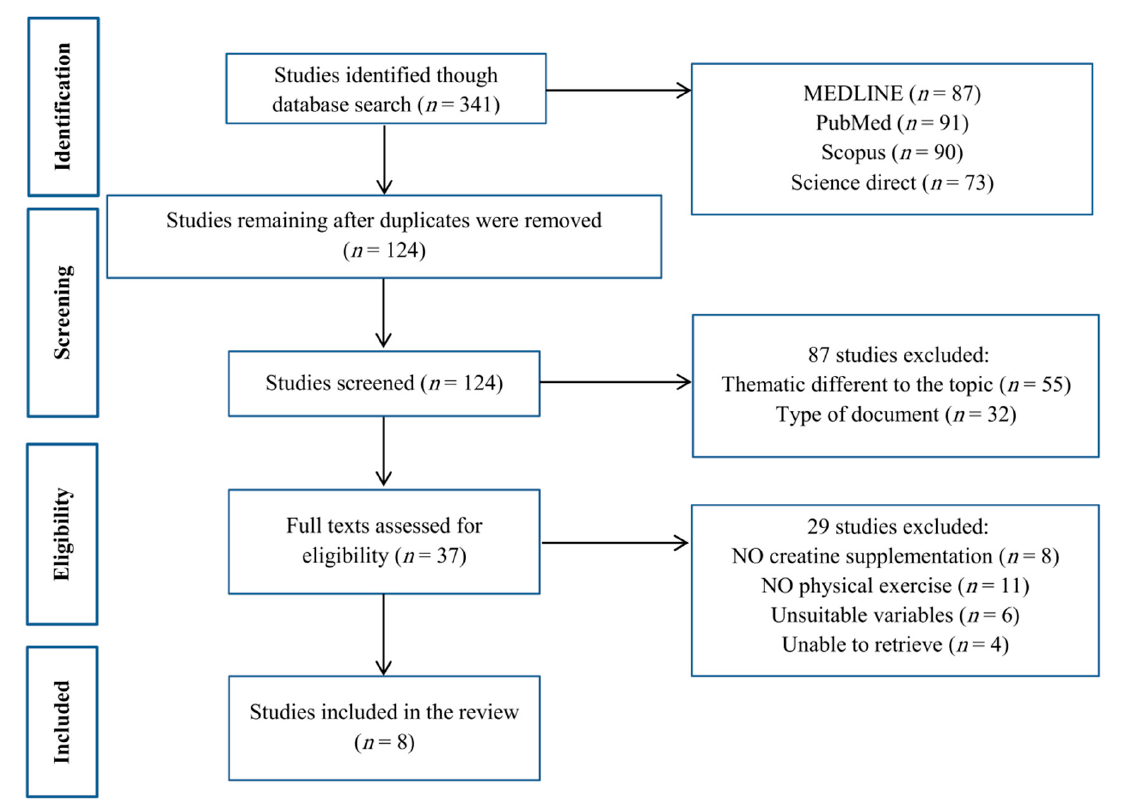
Figure 1. Flowchart of the study selection.